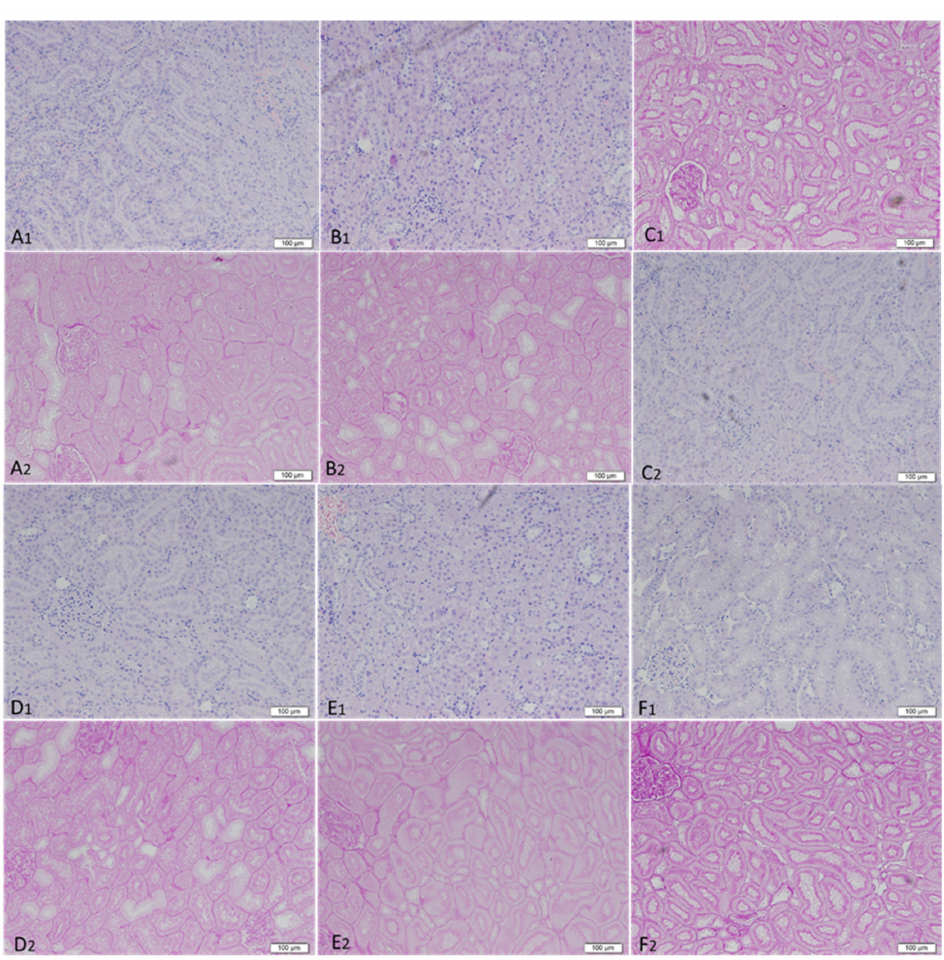
Figure 6. Kidney histopathology in aspirin + Li-treated rats. Rats were fed regular food (control) or lithium-containing food [LLD-Li or STD-Li] for 42 days. Low-dose aspirin (1 mg/kg, ip) was given alone or together with lithium. On day 42, rats were euthanized, kidneys excised, and longitudinally sectioned in half. Then, 2 µ m sections were cut, stained with hematoxylin and eosin, and with Periodic acid–Schiff (PAS) and examined as described in Materials and Methods. Hematoxylin and eosin ( A1 – F1 ) and PAS stain ( A2 – F2 ) × 100 magnifications. Six samples from each group were randomly chosen for assessment. A1,2—Control, B1,2—LLD-Li, C1,2—STD-Li, D1,2—Aspirin, E1,2— LLD-Li + aspirin, F1,2—STD-Li + aspirin. Abbreviations: ASA—acetylsalicylic acid, LLD—low-low dose, Li—lithium, STD—standard dose. No discernible differences were found among the